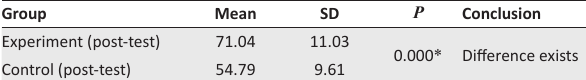
TABLE 4: Comparative test on post-test